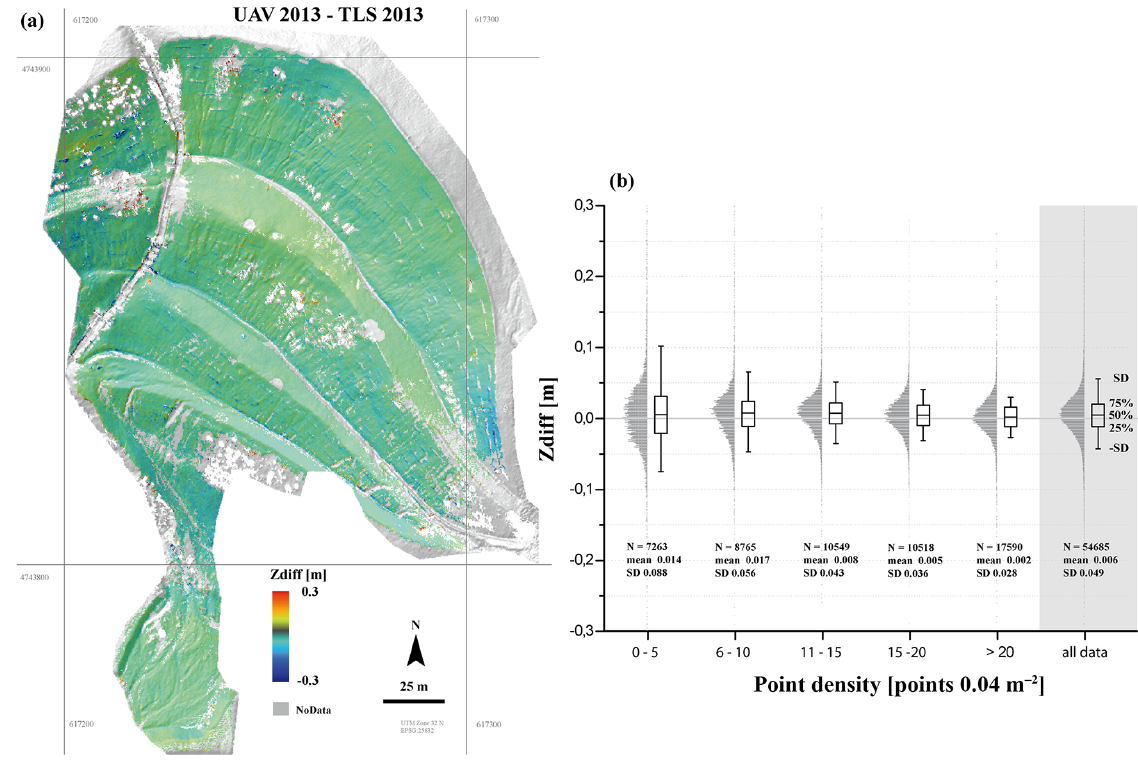
Figure 7. (a) Comparison of the 2013 UAV and 2013 TLS DEMs (not using the LoD) and (b) the distribution of Zdiff (UAV 2013 and TLS 2013; mean value of Zdiff for the whole data is 0.004m) and the dependence of Zdiff from the point density (point density is divided into five classes and presented for the whole data set). Table 4. Sediment balancing (only values over the LoD) for the area of interest (AoI) and separated for the slopes and the reservoir for all epochs of the TLS measurements. AoI Slope Reservoir Epoch Cut Fill Balance Balance Balance 2009–2012 − 75.41m 3 30.78m 3 − 44.62m 3 − 65.82m 3 20.58m